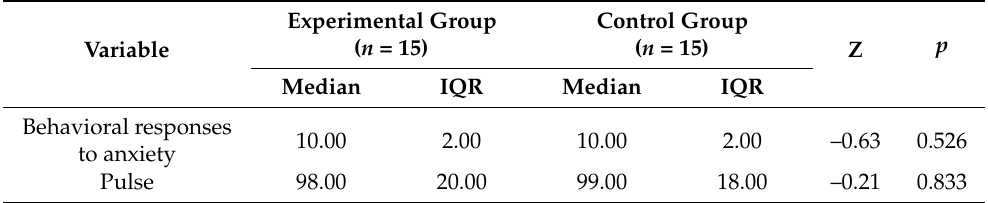
Table 3. Homogeneity of baseline study